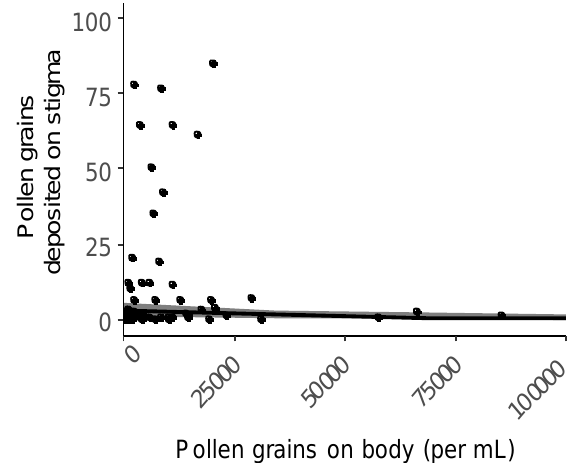
Figure 8. Effect of the number of grains on the body of a pollinator (as present per mL of fluid) on the number of pollen grains deposited on the stigma of a canola flower, with predicted trend line plotted against observed (non- adjusted) points. Shaded area represents 95% CI. The plot was capped at 100 pollen grains deposited on the stigma so that the trendline would be visible, which resulted in the removal of four points which exceeded that